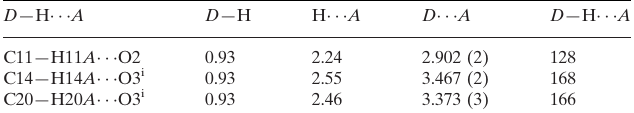
Hydrogen-bond geometry (A˚ , (cid:3)